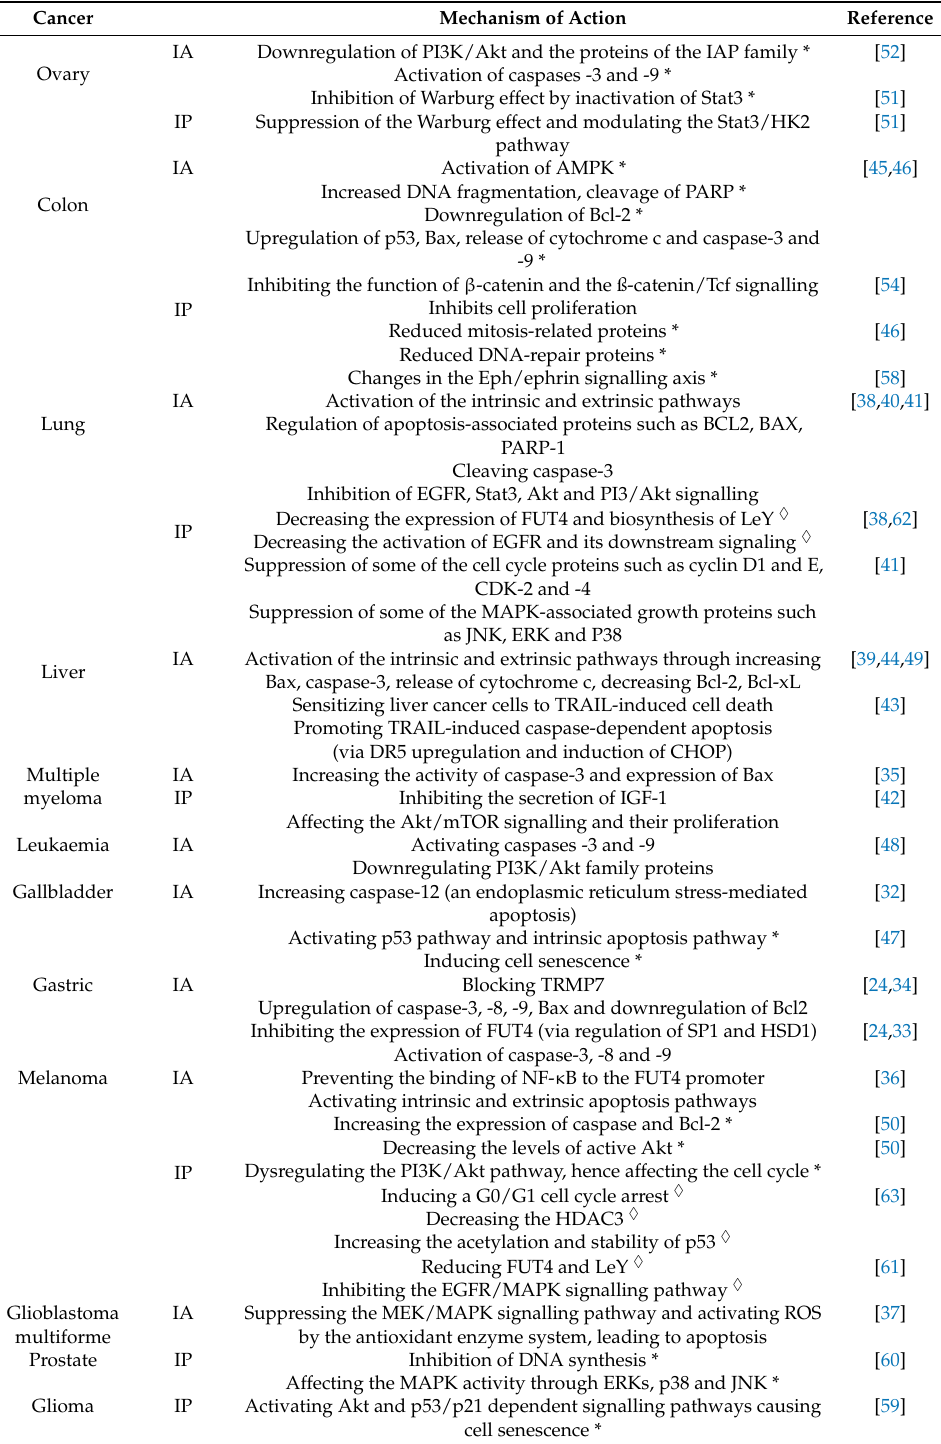
Table 1. Suggested mechanisms for induction of apoptosis (IA) and inhibition of proliferation (IP) by Rg3 in various cancers are summarized in Table 1. The function of different epimers are indicated by ♦ symbols; * and represent 20(S)- and 20(R)-Rg3,